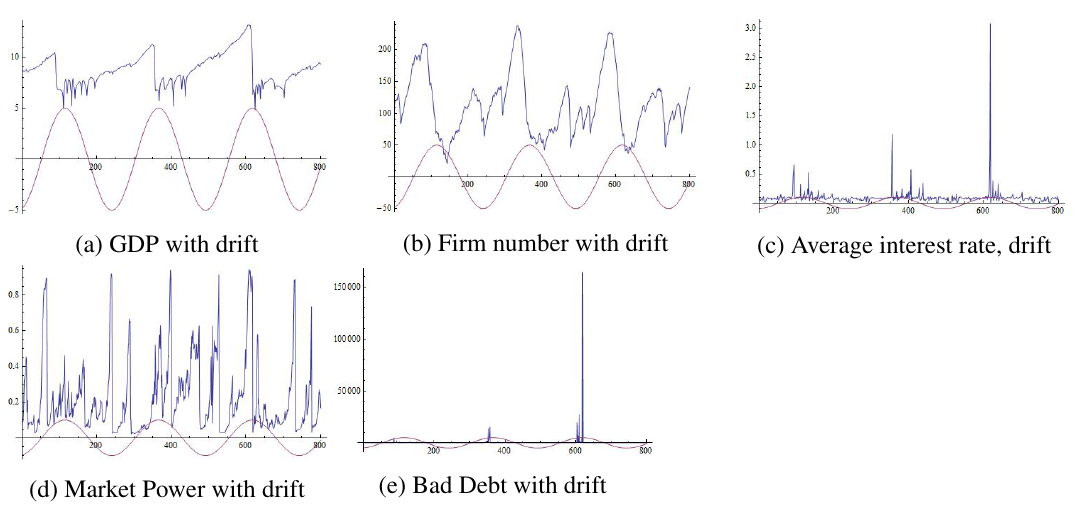
Figure 7: Time Series for high bargaining power of shareholders with stock market